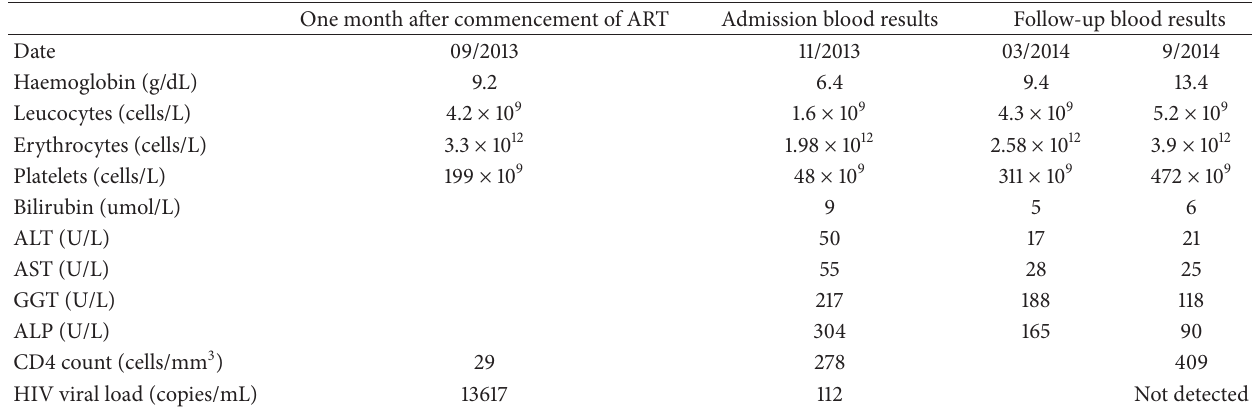
Table 3: Showing baseline and follow-up blood